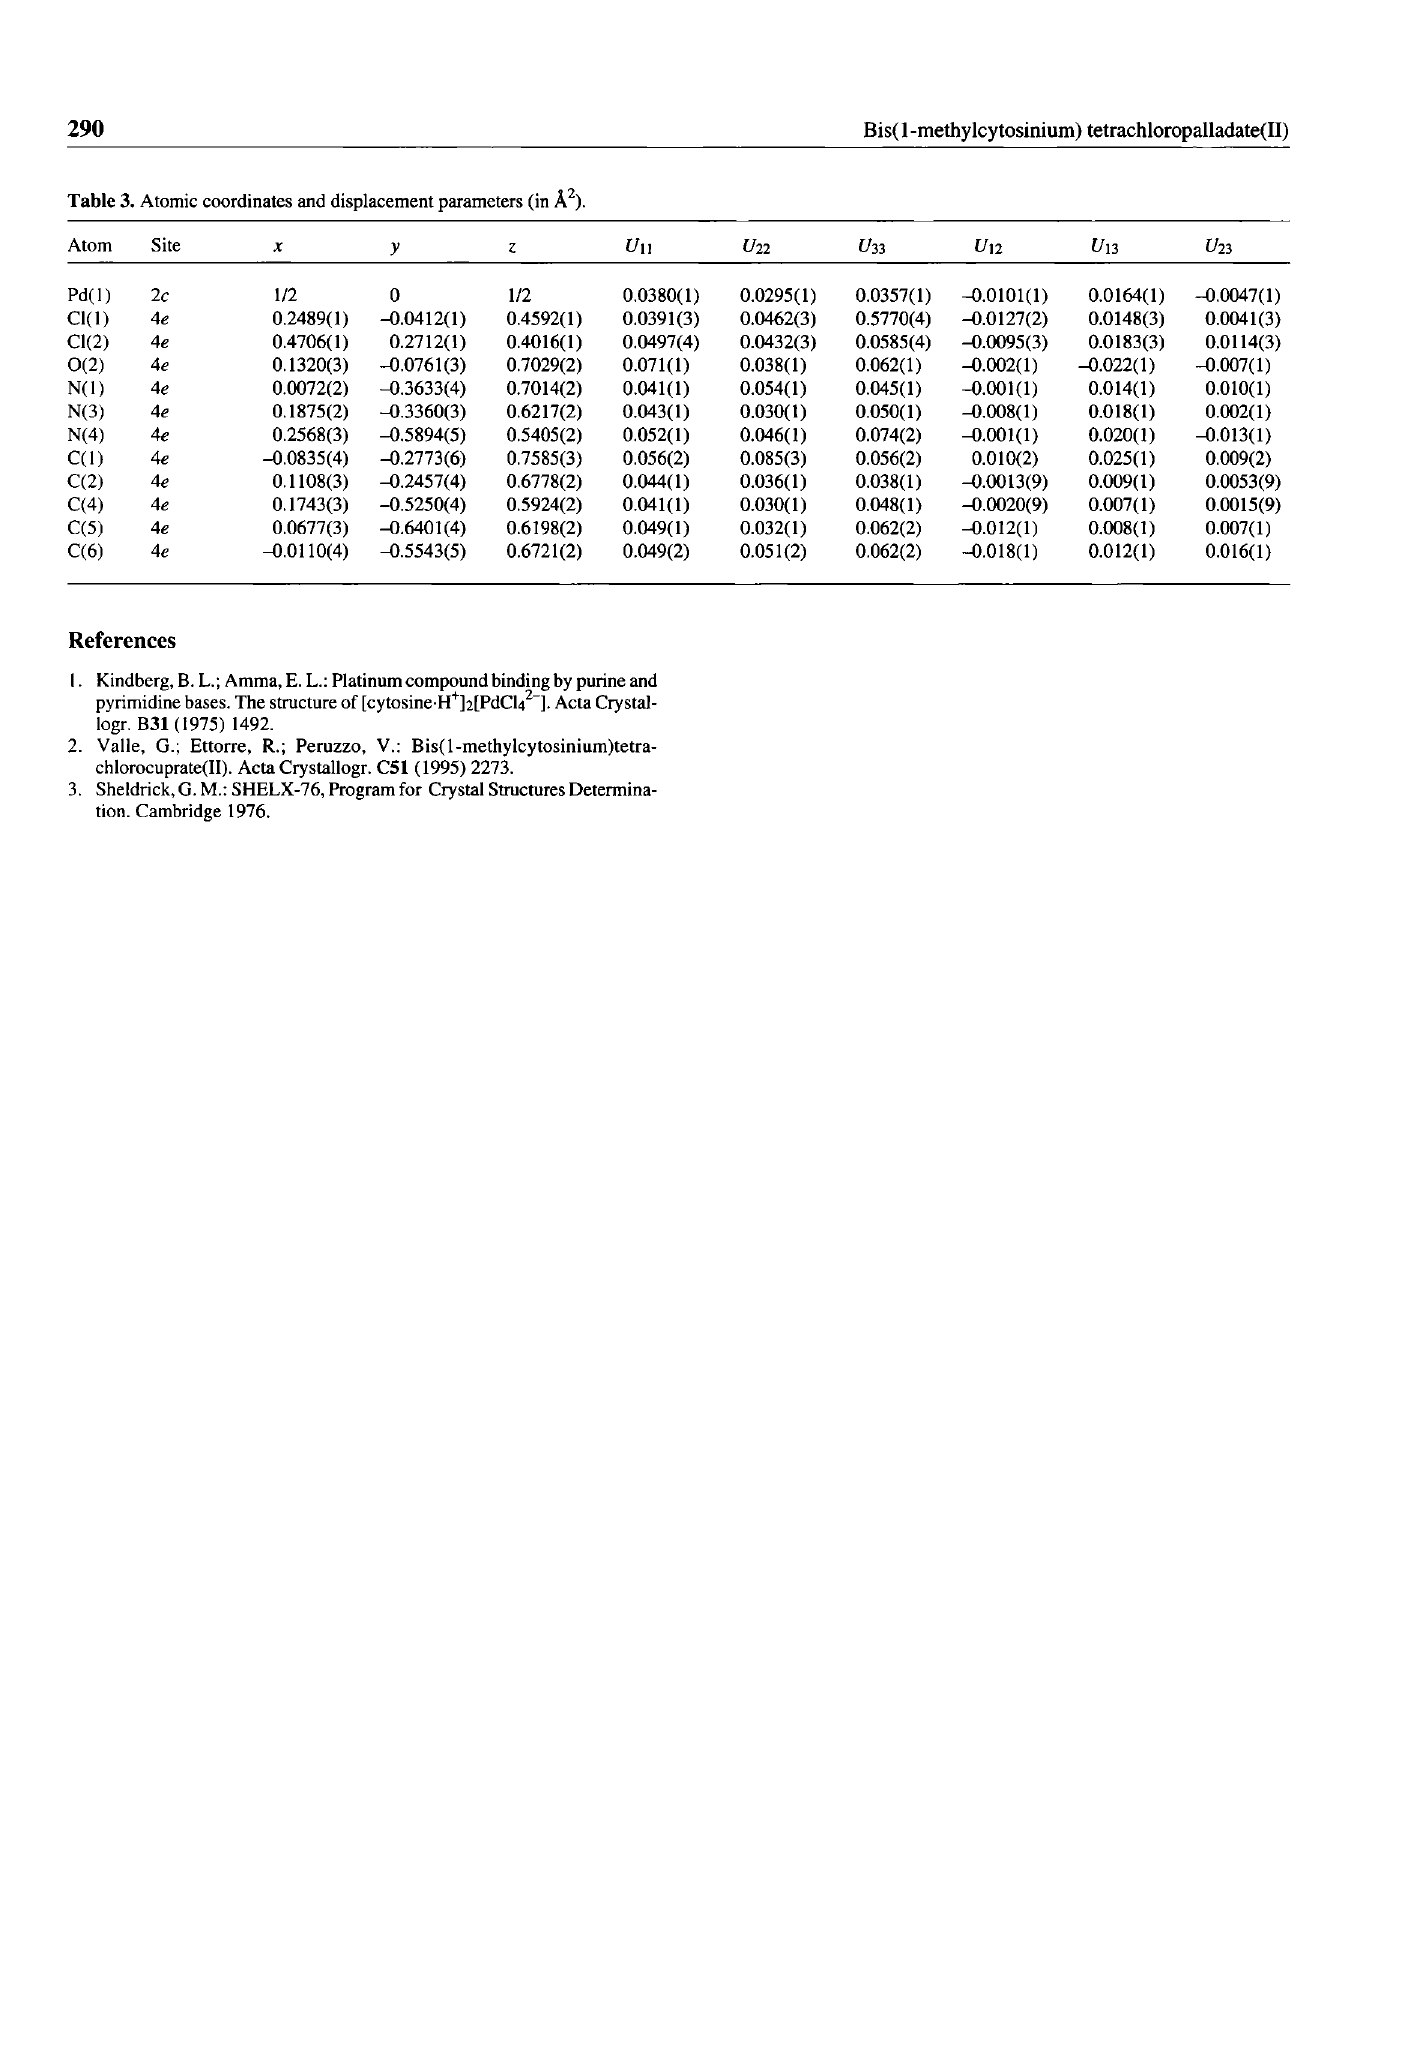
Table 3. Atomic coordinates and displacement parameters (in Ä 2 ). Atom